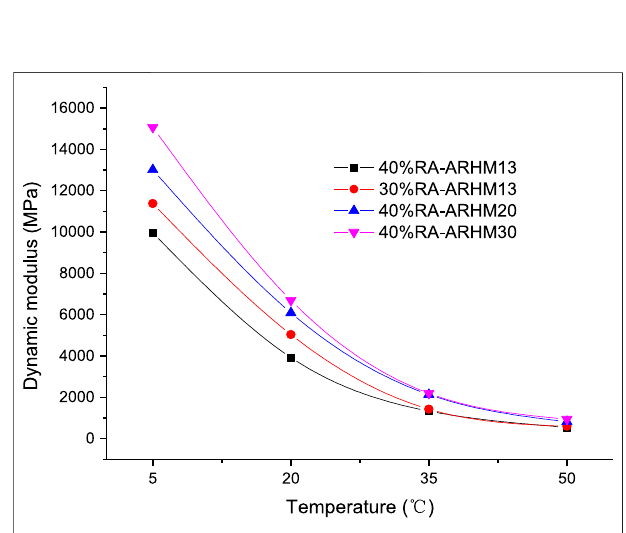
FIGURE 6 | Dynamic modulus and temperature correlation